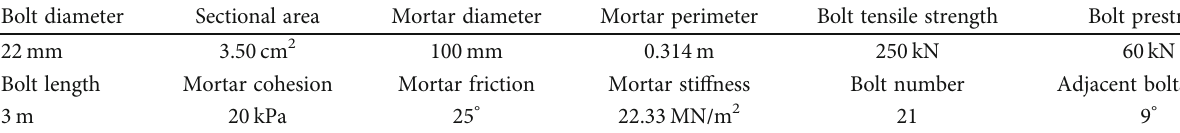
Table 2: Calculation parameters of bolt.